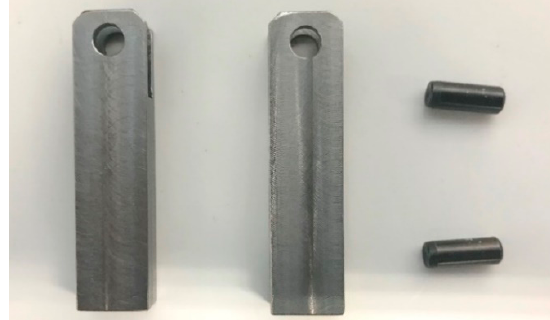
Figure 6. Clevises ( left ) and pins ( right ).